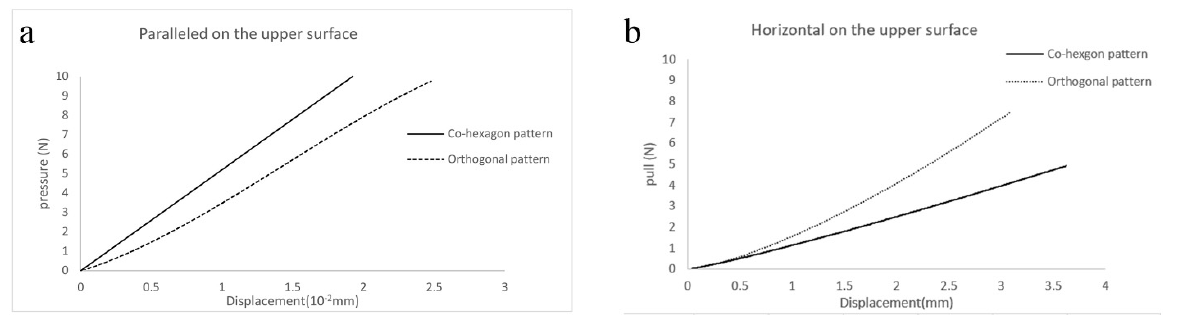
Figure 11. Pressure-displacement curves for orthogonal and hexagonal scaffold ( a ) and tension-displacement curves for orthogonal and hexagonal scaffold ( b ).